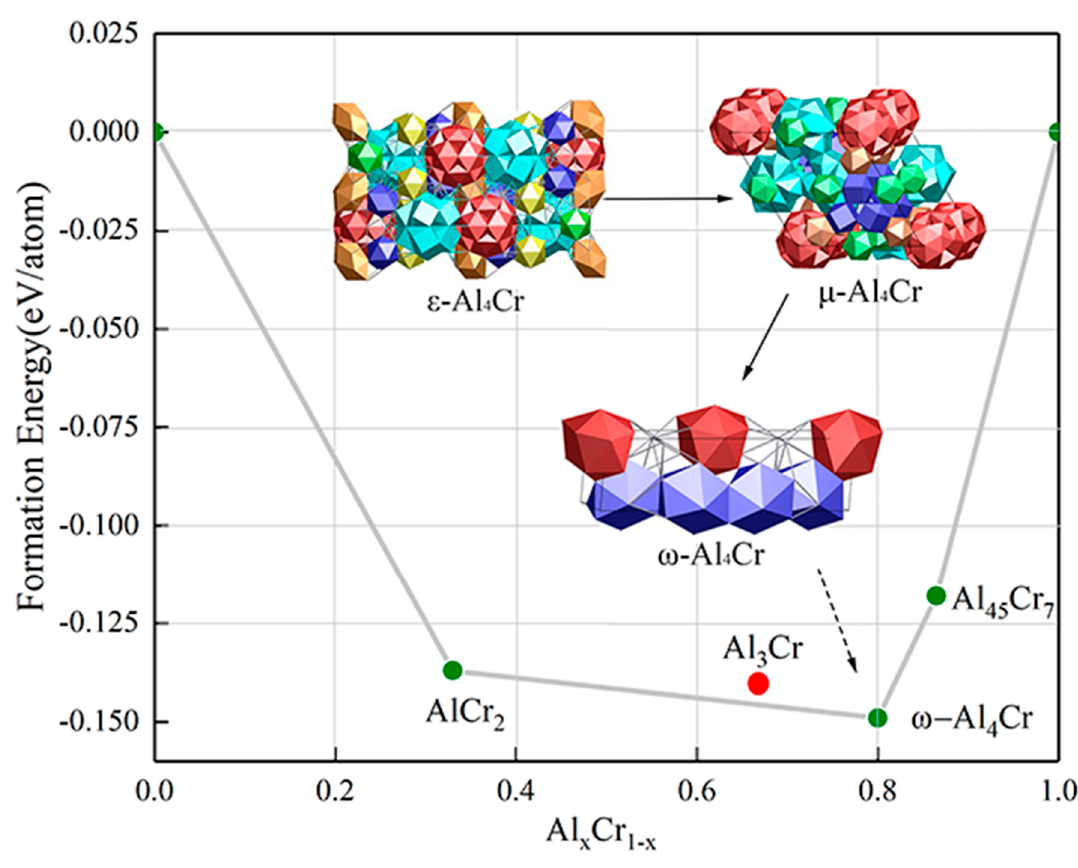
Figure 1. Convhull of the Al-Cr system by first-principles calculations with the proposed phase transition sequences for the ε -, μ - and ω -Al 4 Cr phases in the present work.